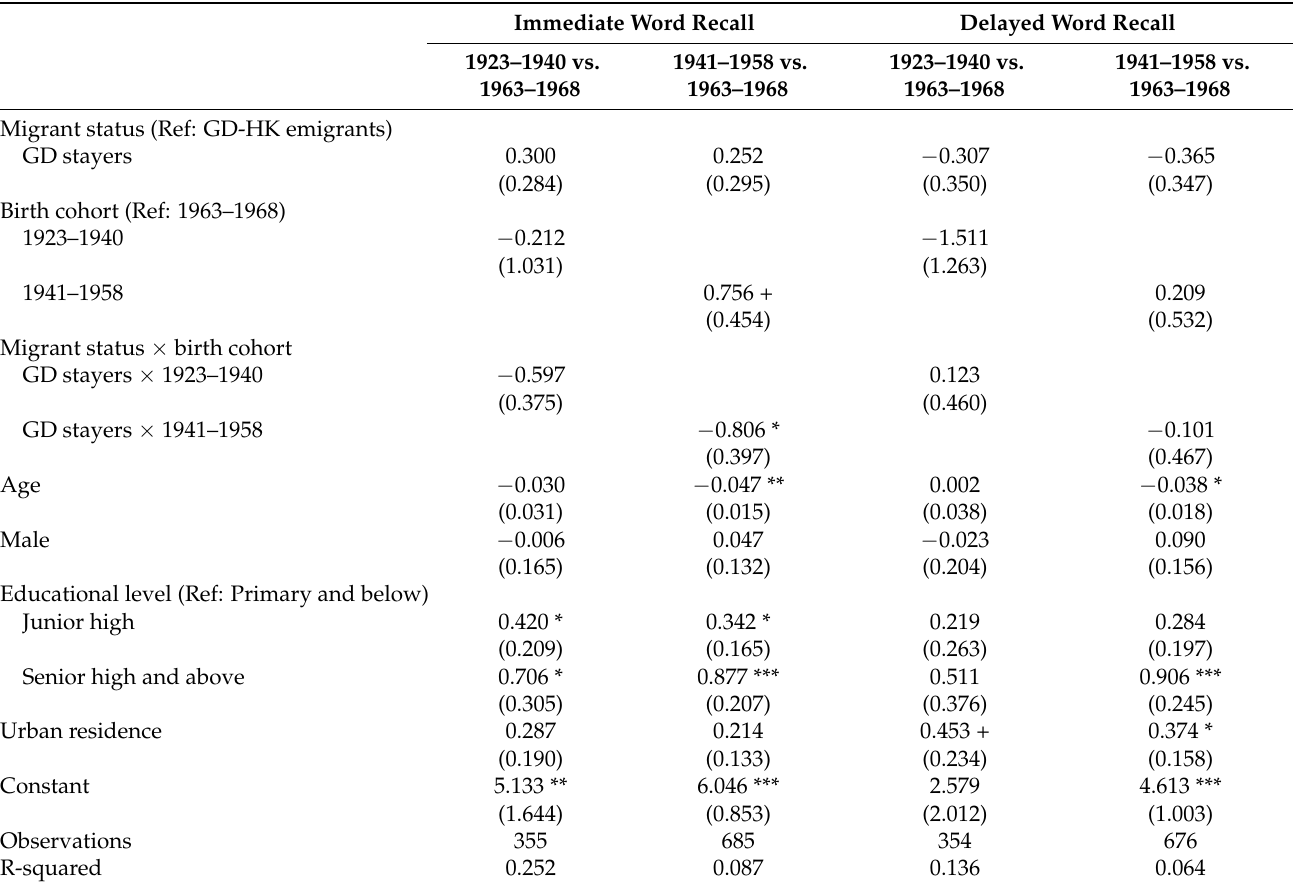
Table 4. Difference-in-differences estimates of famine effects on word recall (the migrant–stayer comparisons